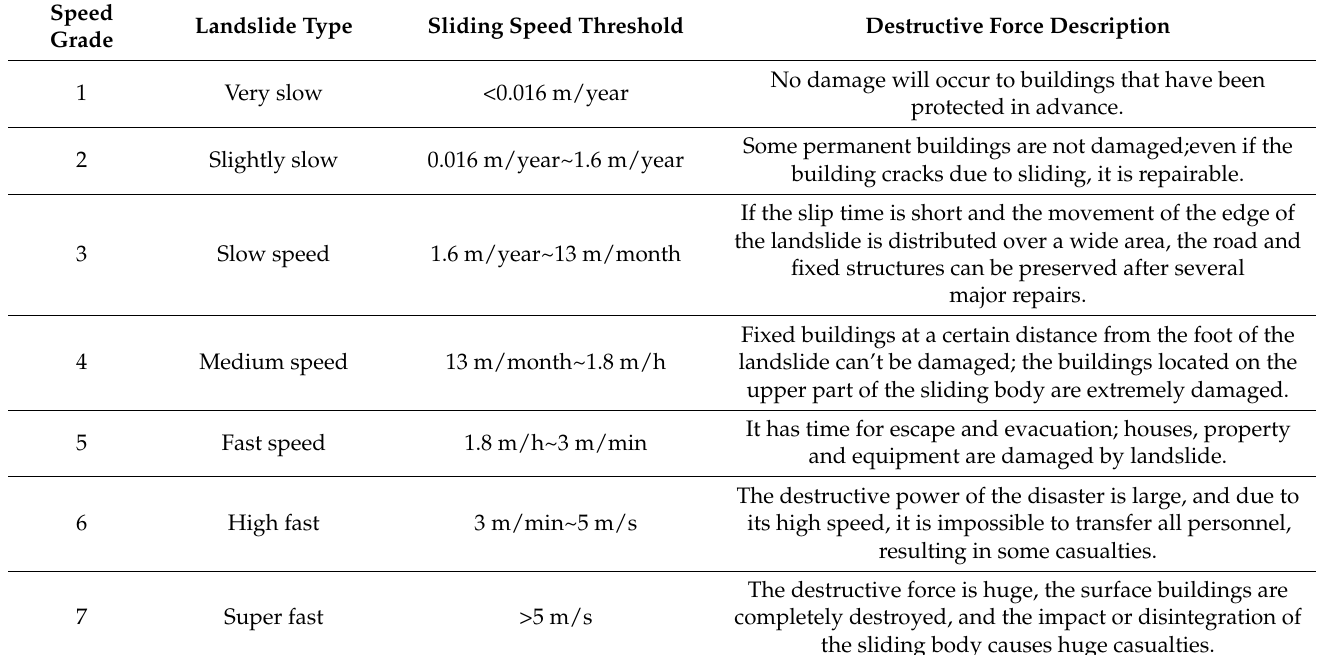
Table 5. Classification of landslide type according to the sliding speed [53].